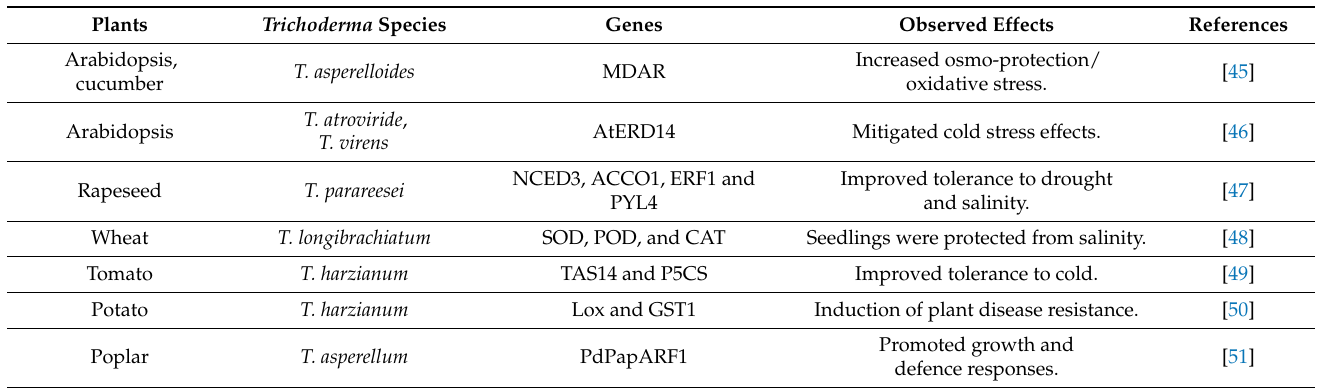
Table 1. Up-regulated genes in some plants upon Trichoderma